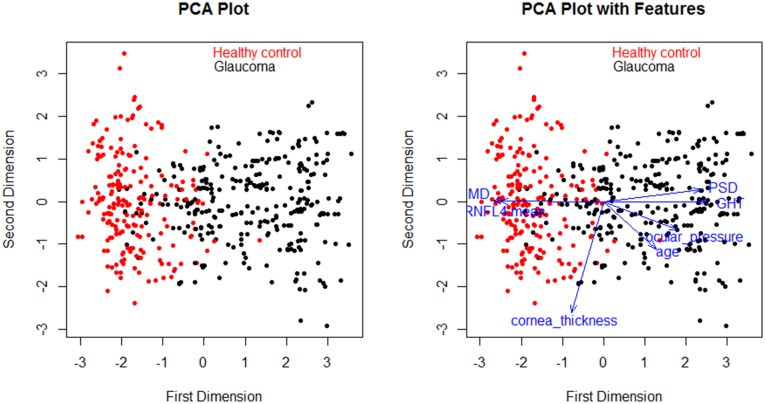
PCA plot for prepared dataset.Each point means a case in the dataset. Generally, the glaucoma cases are well separated from the healthy control cases. Some cases are located in the border area or opposite area. Right plot shows relationship between distribution of cases and features. In the glaucoma group, PSD, GHT, ocular_presure, and age have high values whereas MD and RNFL4_mean have low values.